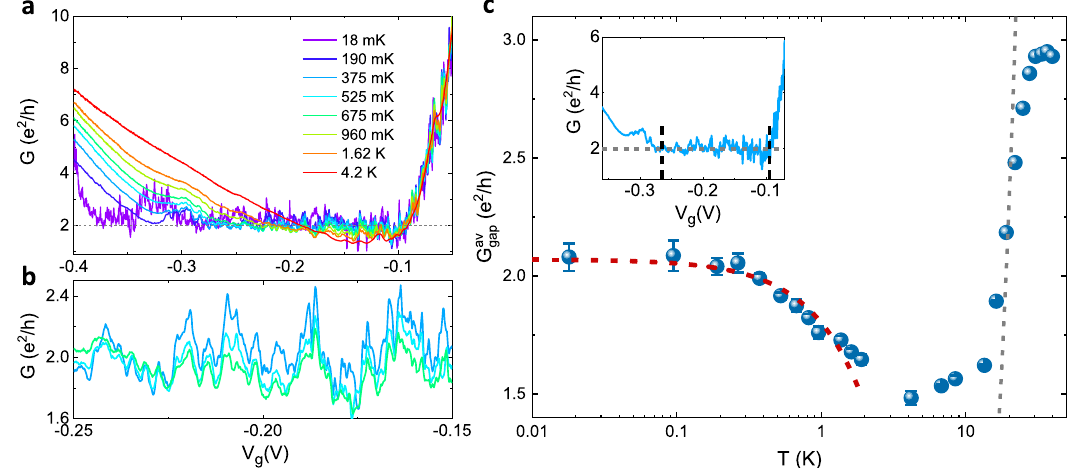
Fig. 3 Effect of temperature on the quantized conductance. a The conductance G as a function of gate voltage V g at different temperatures from 18 mK to 4.2 K. The dotted line indicates the expected conductance of 2 e 2 / h in the quantum spin Hall regime. b Magni fi ed view of G as a function V g for different temperatures to show the reproducibility in conductance fl uctuations. c The average conductance in the quantum spin Hall regime G av as a function of gap temperature T . The blue points are the experimental data and the red dashed line shows the power-law Kondo fi t (see main text). The gray dashed line = 2 k shows the expected thermally activated conductance [ / exp ð(cid:4) E T Þ ] for a band gap of E g = 10 meV (from the band structure calculations shown in g B Fig. 1). The inset shows a typical G – V g dependence from which G av (shown by dashed horizontal line) is calculated by averaging over the conductance gap values in the plateau region between the dashed vertical